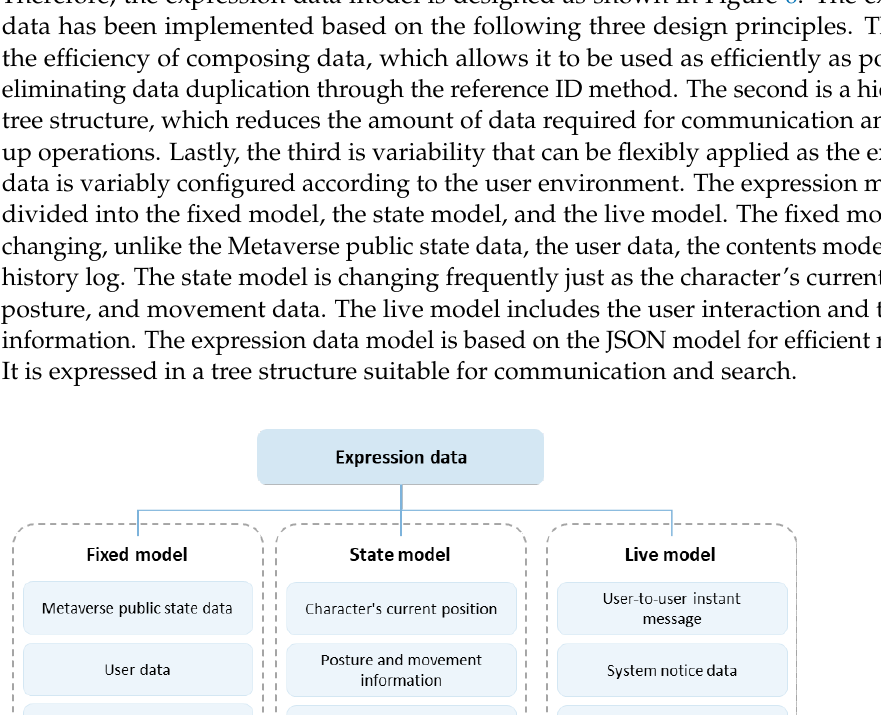
Figure 5. Storage data model entity.